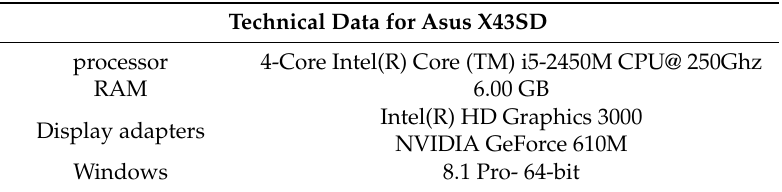
Table 2. The computer system characteristics.